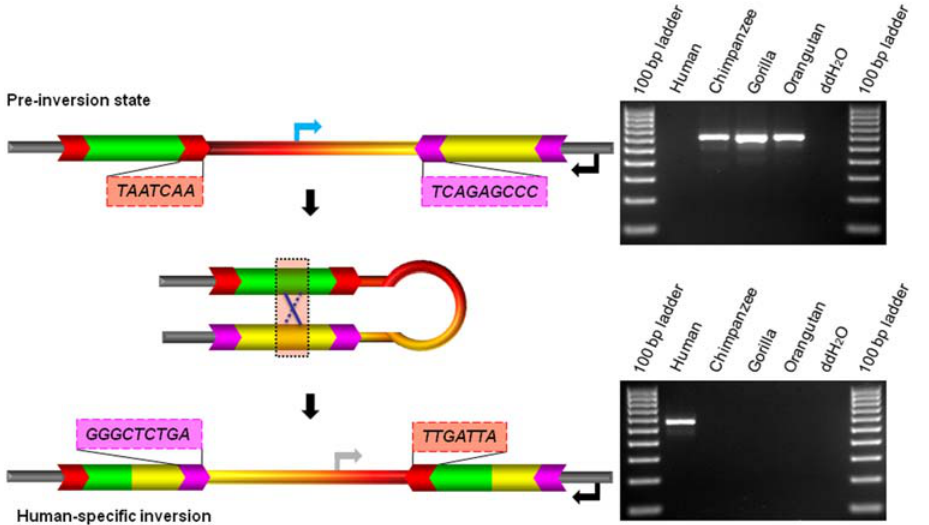
Figure 5. RRMI between human and chimpanzee lineages. The mechanism underlying RRMI is shown at the left. In the illustration of the ancestral state, the two retrotransposons have intact TSDs whose sequence is listed in the colored boxes. The shape ‘‘X’’ indicates recombination between the retrotransposons. In the illustration of the human-specific inversion, both retrotransposons are chimeric, and no longer have matching TSDs. For both illustrations, two arrows indicate the positions where each oligonucleotide primer anneals to for PCR amplification. Agarose-gel chromatographs of PCR products are shown on the right. The upper gel picture displays the ancestral state of the RRMI, while the lower gel picture displays the human-specific inversion. The DNA templates used in each PCR reaction are shown on top of the gel pictures. Table S2 Primer information for RRMI loci